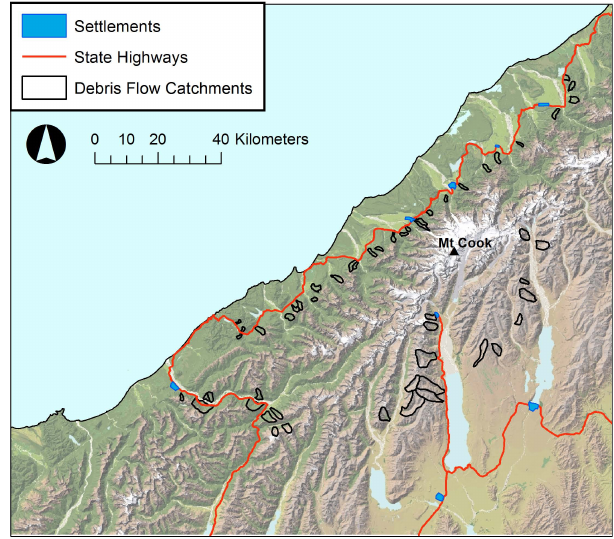
Fig. 9. River catchments in the central Southern Alps capable of generating debris flows. Table 5. Volume comparison of landslide deposits generated by the 2008 Wenchuan earthquake and rainfall induced debris flows resulting from these deposits, during the 2010 rainstorm events from Qingping and Zoumaling catchments. Adapted from Xu et al.